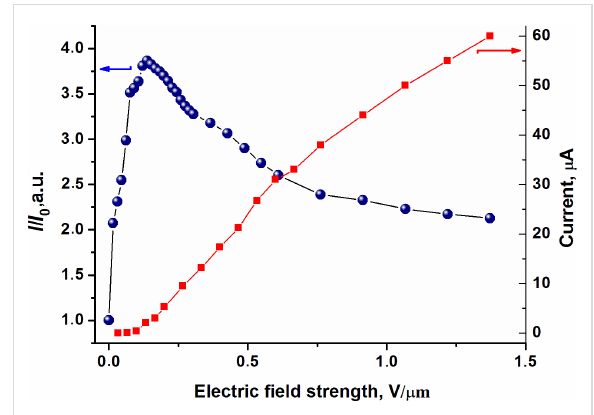
Figure 4: Change in the PL intensity (blue circles) and ion current (red circles) in the active LC matrix with 1 wt % CdSe/ZnS QDs as a func- tion of the electric field